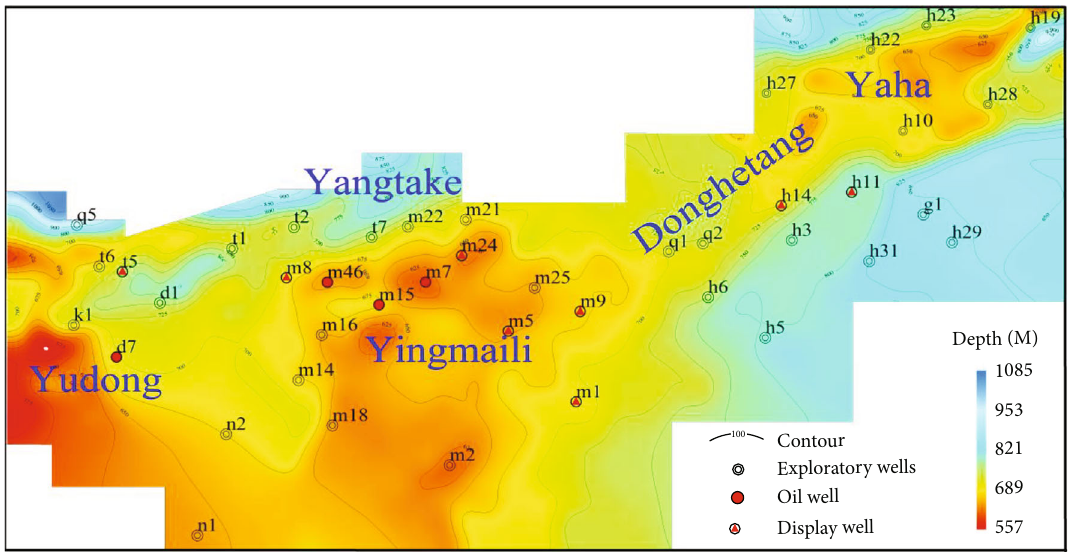
Figure 7: Cretaceous paleostructure before deposition of the Kangcun Formation in the western Tabei